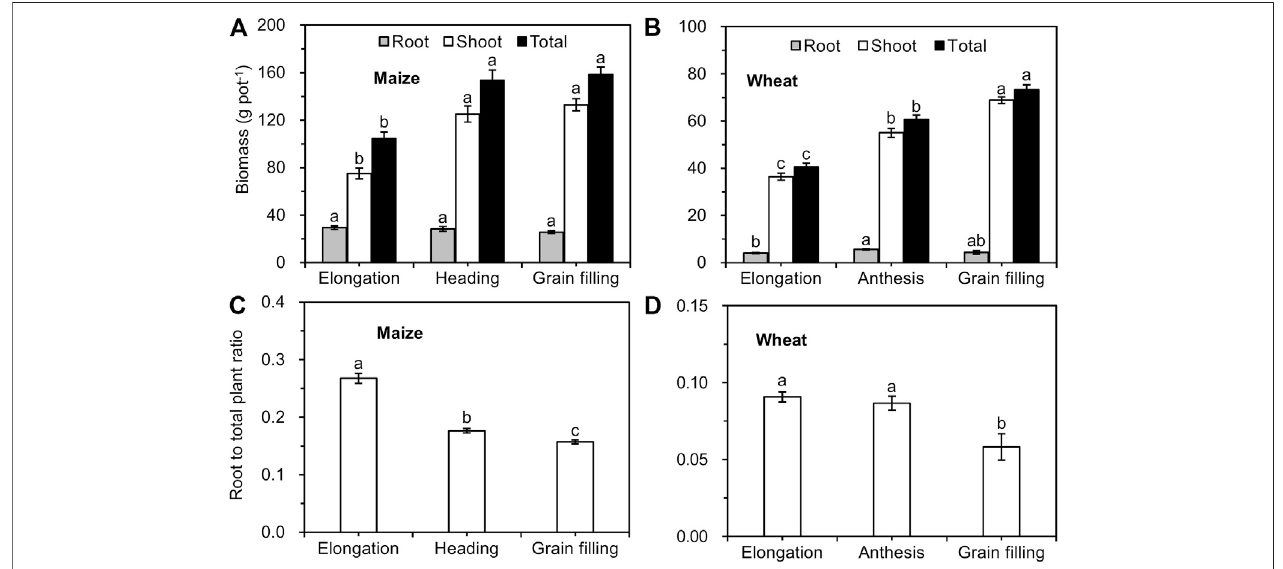
FIGURE2| Biomass ( A, B ) and root/total plant weight ( C, D ) ofmaize and wheat at differentgrowth stages (mean ± SE, n (cid:2) 3for maizeand n (cid:2) 4 forwheat). Note: Different lowercase letters indicate signi fi cant differences between growth stages at the p < 0.05 level.